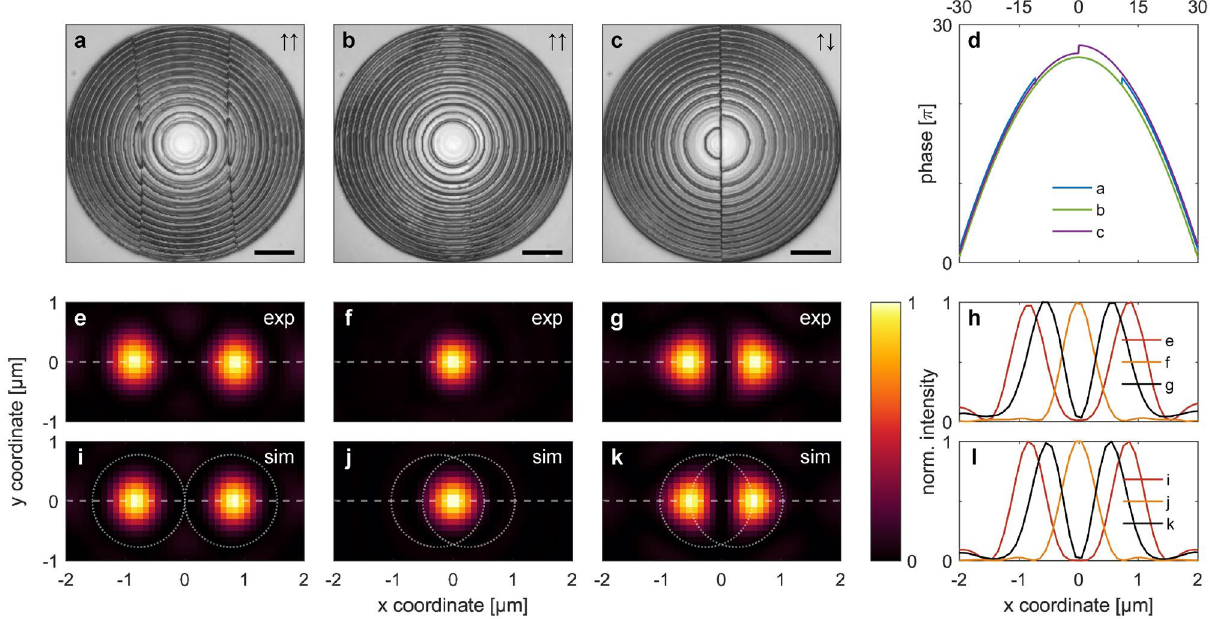
3D nano-printed holograms in the aperture plane: ( a ) ↑↑ /Λ 1 , ( b ) ↑↑ /Λ 3 , ( c ) ↑↓ /Λ 3 (scale bar 10 µm). ( d ) Corresponding unwrapped phase profiles of the distributions shown in ( a )–( c ) along y = 0 . ( e )–( g ) Measured intensity in the focal plane from the holograms shown in ( a )–( c ) with the intensity profiles along y = 0 (horizontal dashed lines) shown in ( h ). ( i )–( l ) Corresponding simulated patterns for the scenarios in ( e )–( h